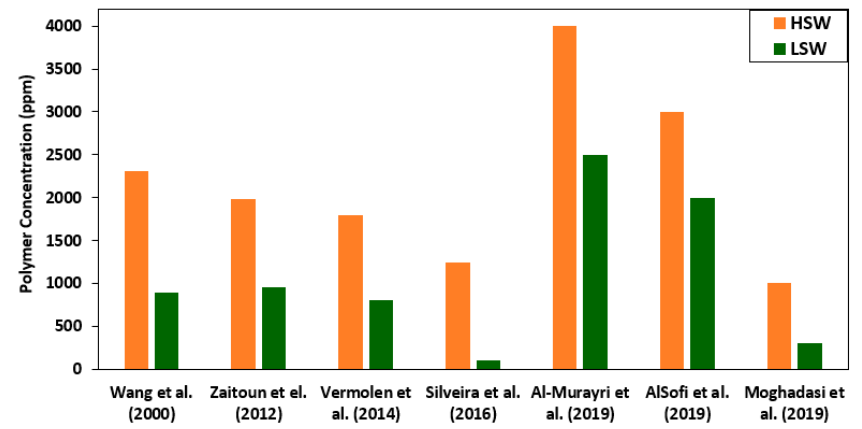
Figure 9. Studies showing reductions in the required polymer concentrations using LSW compared to high salinity water (HSW).